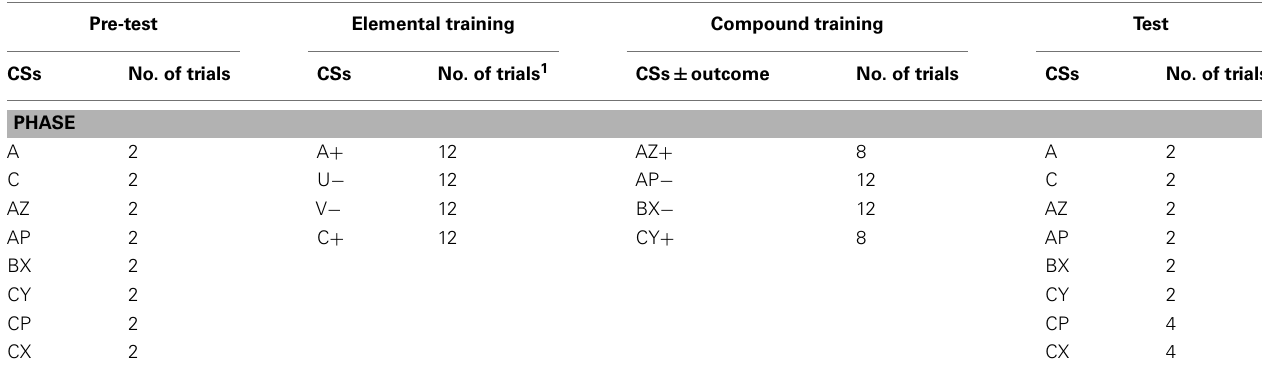
Table 2 |The design of the experiment used in the third variant of the